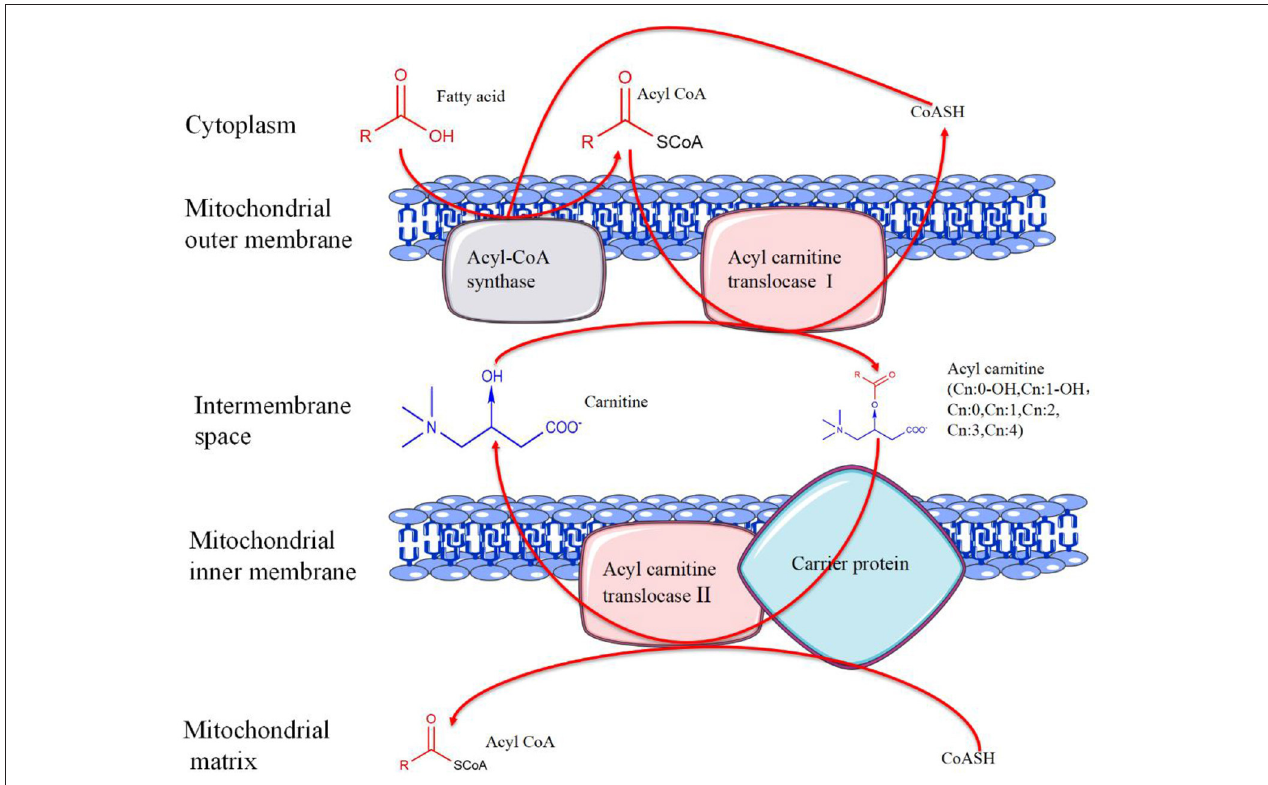
FIGURE 2 | The metabolic process of carnitine. In the presence of coenzyme A (CoA)-SH, fatty acids are catalyzed by acyl-CoA synthase in the outer mitochondrial membrane to generate acyl-CoA. Activated acyl-CoA is transported into the mitochondria under the action of acylcarnitine translocase I with the help of carnitine and carrier protein, and acylcarnitine is produced at the same time. Subsequently, acylcarnitine releases carnitine under the action of acylcarnitine translocase II to produce acyl-CoA. Finally, acyl-CoA enters the mitochondrial matrix for further